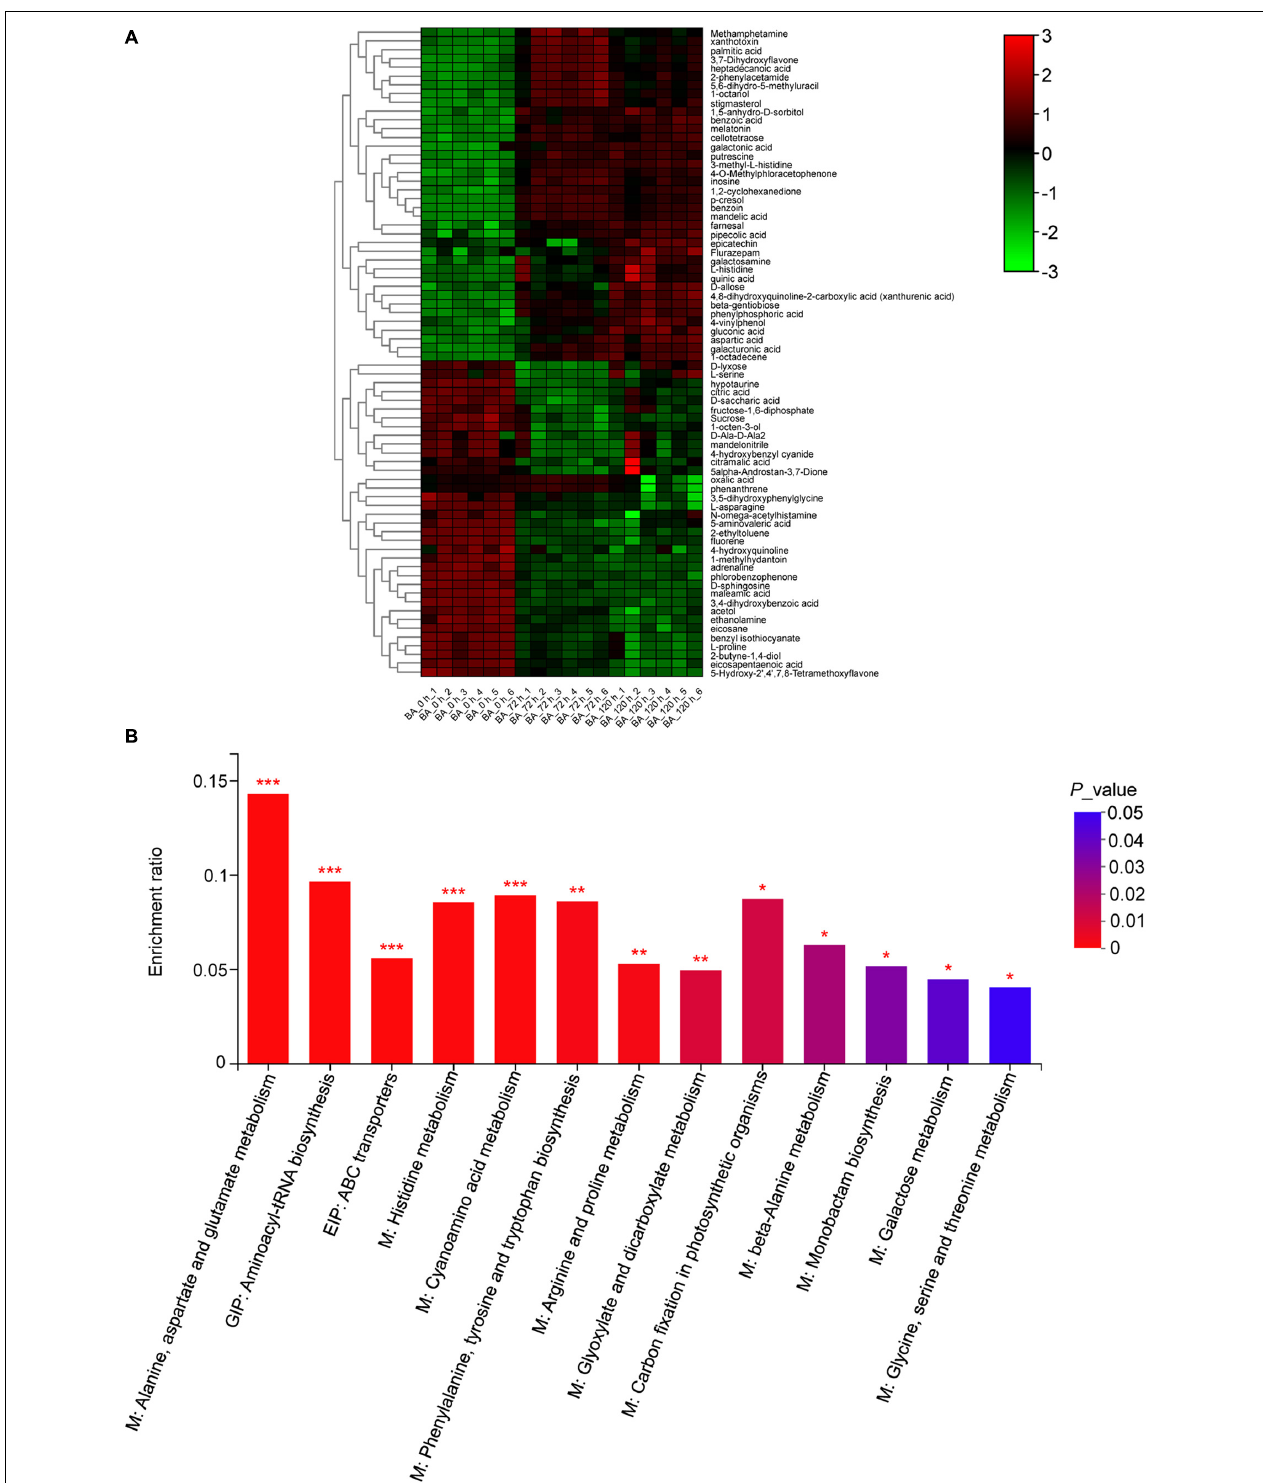
FIGURE 6 | Metabolic changes in the BA-treated peach roots. (A) Hierarchical cluster heatmap of differently accumulated metabolites (DAMs) treated with BA for 0, 72, and 120 h. The color changed from green to red, indicating that the abundance of metabolites gradually increases. (B) KEGG enrichment results of DAMs. M, metabolism; GIP, genetic information processing; EIP, environmental information processing. The y -axis shows the ratio of DAMs to the total background metabolites number in each pathway. The color of the bar changed from blue to red, indicating that the P- value gradually decreases. Asterisks on top of bars represent * P- value < 0.05, ** P- value < 0.01, and *** P- value < 0.001.